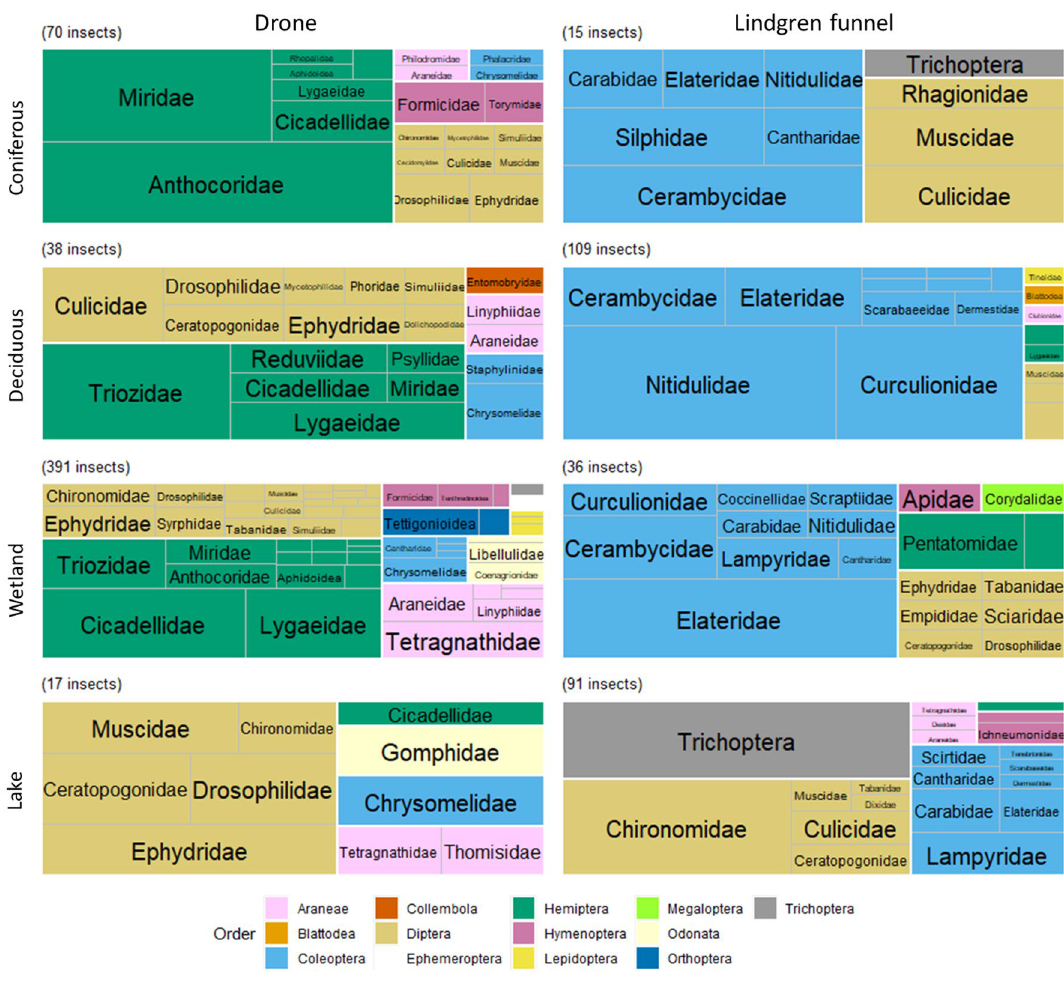
Figure 7. Treemap of arthropod sample composition collected by two methods; drone and hanging sweep net (left) and Lindgren funnel (right). Family and Order are grouped together for each habitat; Coniferous forest, deciduous forest, wetland, and lake. Boxes represent total proportion of the arthropod order compared to total arthropods caught at three different sites of each habitat. Total insects collected are marked above each treemap. Shannon-Weiner diversity index Habitat